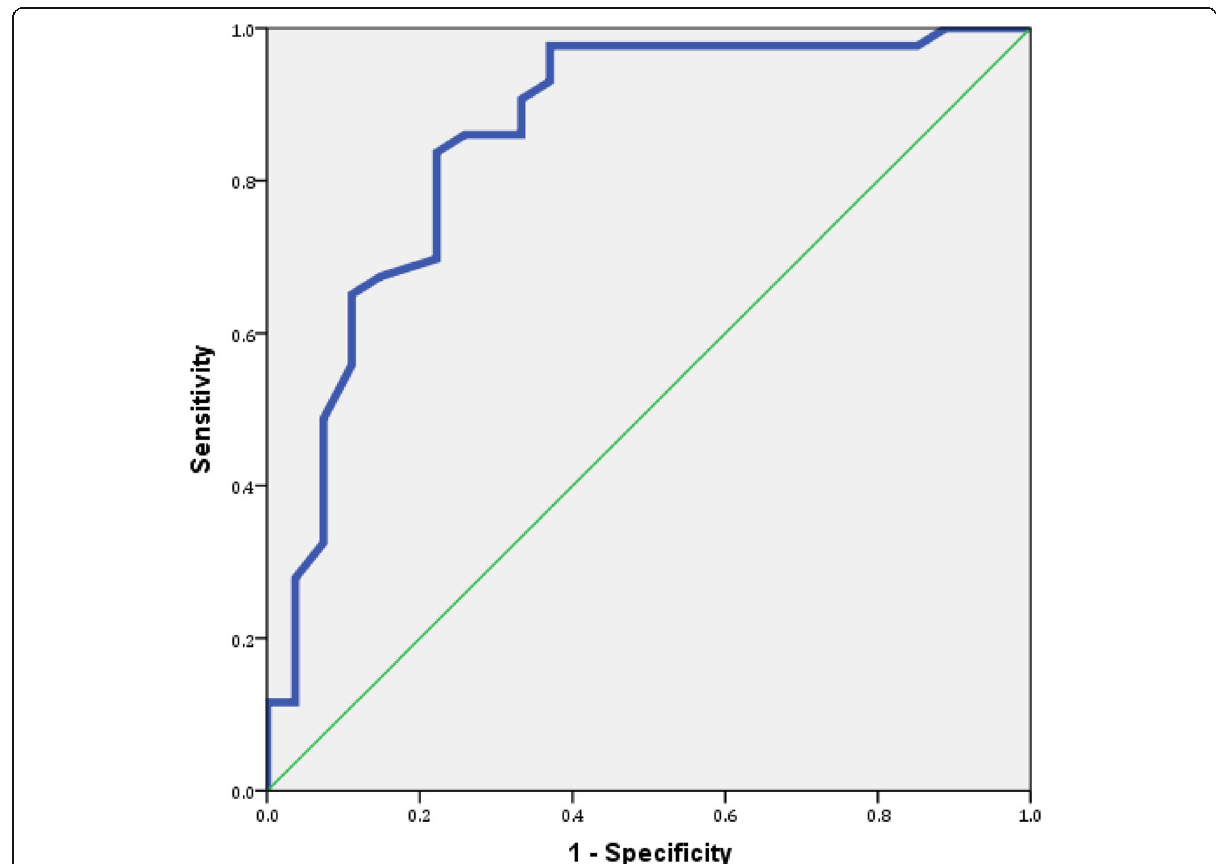
Fig. 3 ROC curve showing performance of FENO in diagnosis of eosinophilia among the studied